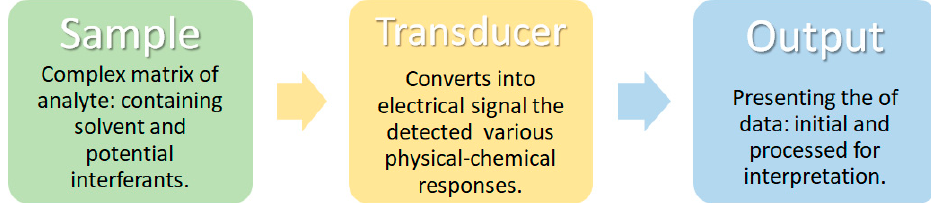
Figure 1. Diagram for manufacturing an analytical device based on